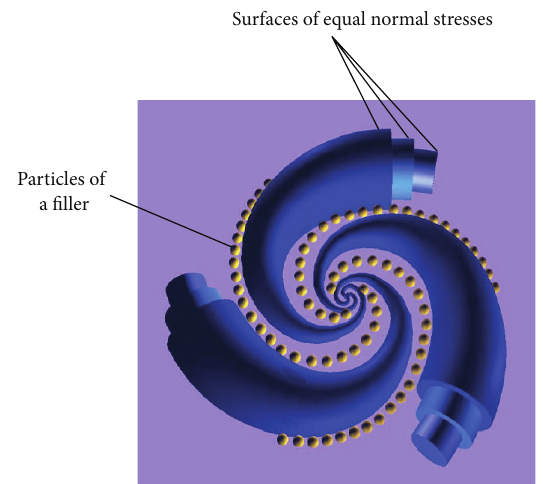
Figure 12: Graphic illustration of the distribution of solid particles in the strong rotation shear